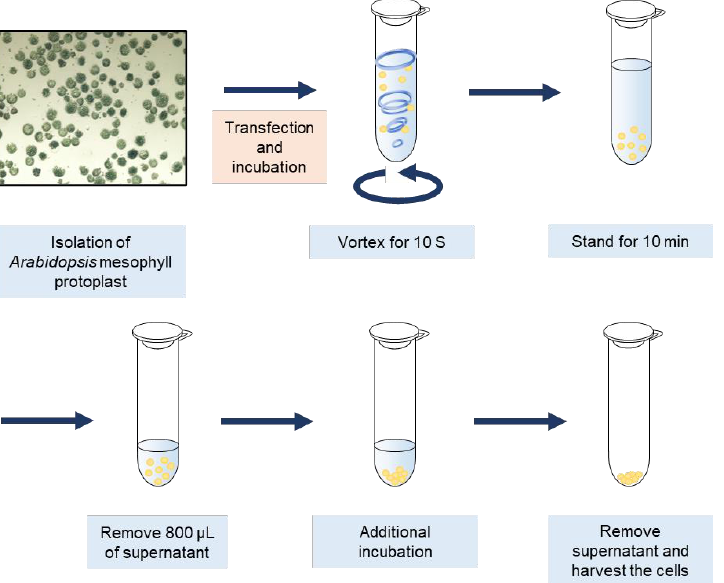
Figure 1. Schematic representation of vortex-induced wounding in Arabidopsis mesophyll protoplasts. Arabidopsis mesophyll protoplast (AMPs) were isolated and transfected with transiently expressing DNA, followed by incubation for desired time. Wounding was induced by vigorous vortexing for 10 s, followed by incubation for 10 min. The supernatant was removed to reduce hypoxia, followed by further incubation. Protoplasts were harvested after the complete removal of the supernatant.